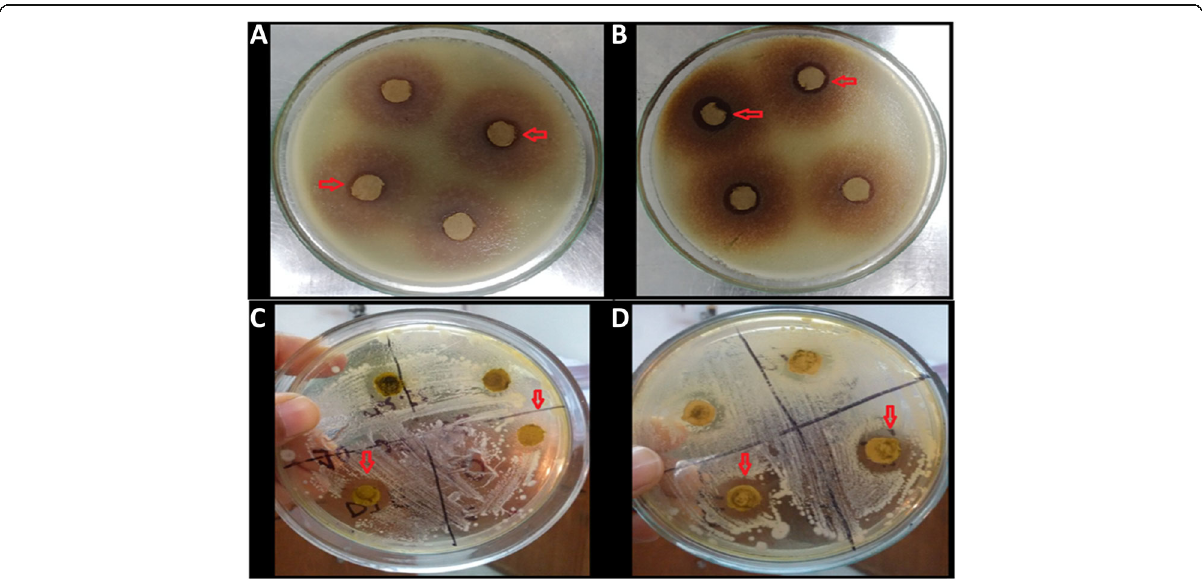
Fig. 2 Images of MIC (minimum inhibitory concentration) test. a & b were 5 mg/ml of methanolic and ethanolic extracts of Desmodium triflorum (L.). c & d were 15 mg/ml of methanolic and ethanolic extracts of Desmodium triflorum (L.). Each sample was replicated as n = 4. The zone of inhibition is indicated in the red arrow